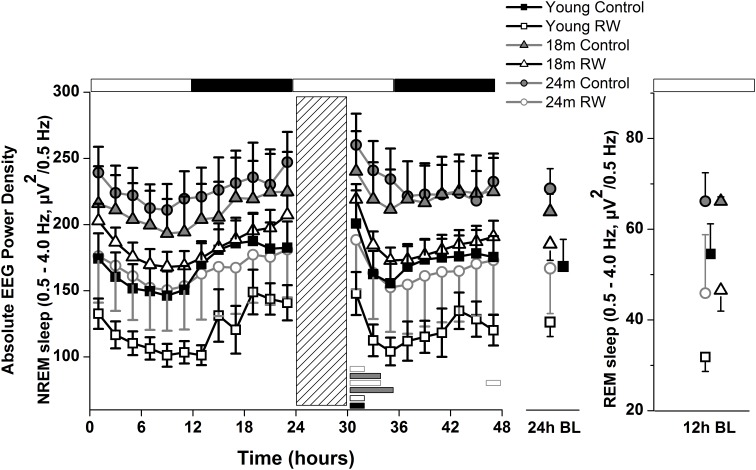
Time course of absolute electroencephalographic (EEG) power for the slow-wave activity range (SWA, 0.5–4 Hz) in non-rapid-eye movement (NREM) sleep for 24-h baseline (BL), 6-h sleep deprivation (SD, hatched bar) and 18-h recovery for control and running-wheel (RW) mice (left), 24-h baseline (BL) EEG SWA data in NREM sleep (middle) and 12-h BL EEG SWA in REM sleep (right). EEG SWA in NREM increased as a function of aging, and decreased with the use of a running wheel. Bars at the bottom of each graph significant differences between recovery and BL day for each age and condition (post hoc Bonferroni multiple comparisons correction t-tests, p < 0.05 after significant ANOVA, main effects ‘group,’ ‘treatment,’ ‘time of day,’ ‘day’).